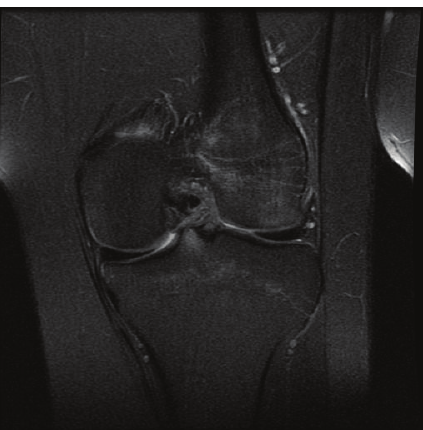
Figure 1: Preoperative coronal MRI scan of the left knee demon- strating a full thickness tear of the anterior cruciate ligament with a typical pattern of bone bruising of the lateral femoral condyle and posterior aspect of the lateral tibial condyle.